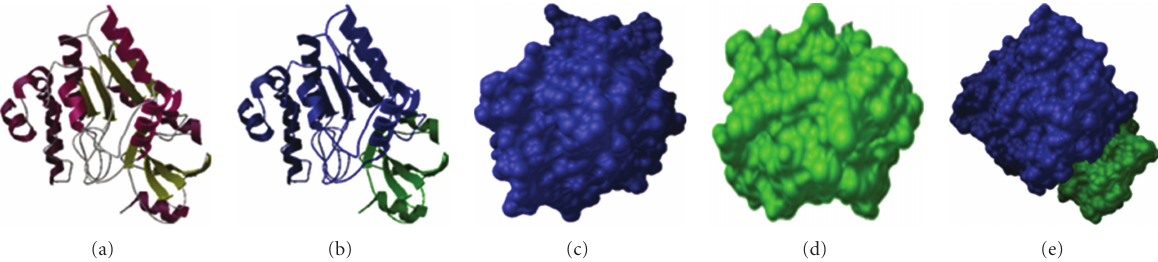
Figure 1: Protein structures for a sample protein (PDB id: 2UDI). (a) Secondary structure elements— α -helixes (magenta), β -sheets (gold), and turns (gray); (b) two chains: chain E (blue), chain I (green); (c) surface and 3D shape for chain E; (d) surface and 3D shape for chain I; (e) quaternary structure for the protein. Figures are produced using PMV